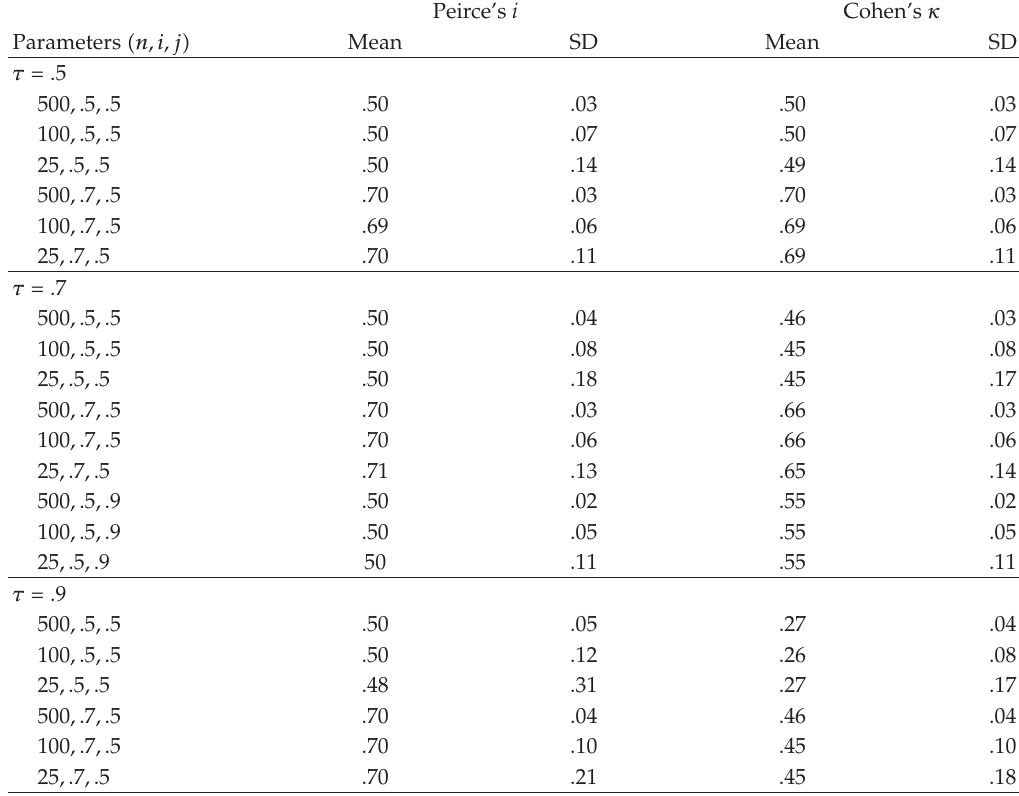
Table 1: Descriptive statistics of i and κ